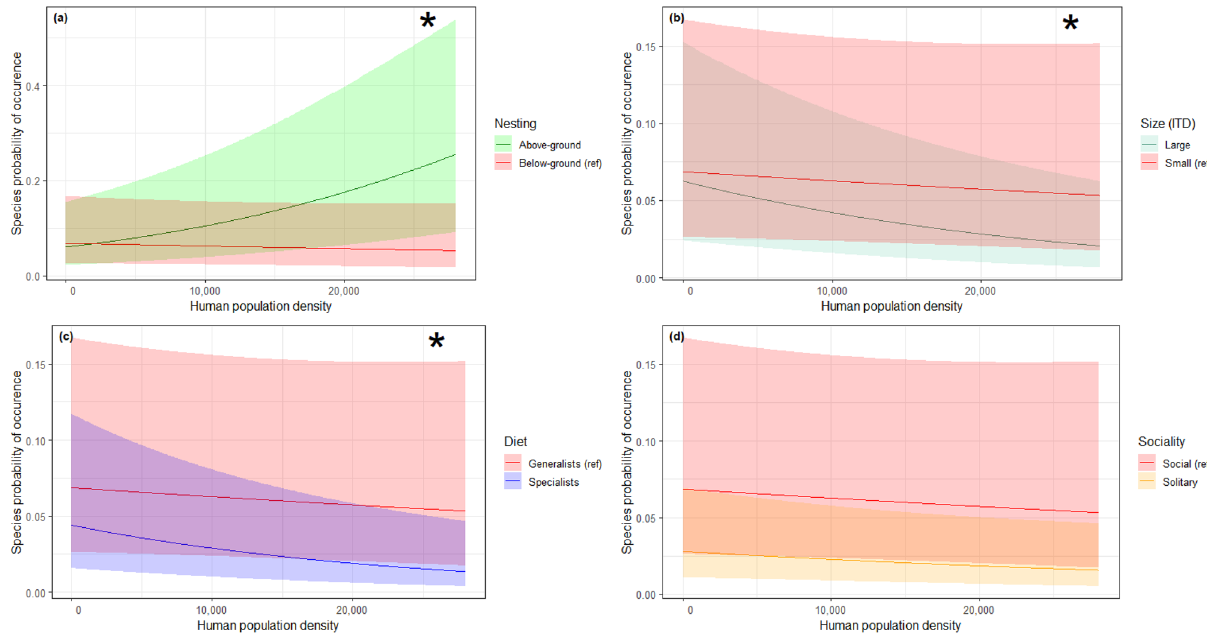
Figure 3. Bee species probability of occurrence as a function of human population density and functional trait modalities. Model predictions are plotted separately by trait modalities, so as to highlight the statistical interactions that may support an ecological filter hypothesis, i.e. different slopes between two modalities of a given trait. In each panel, the reference modality handled by the model (red curves, with a “ref” legend tag) was chosen on the basis of the most abundant species in the dataset, namely Lasioglossum malachurum , a small-sized species nesting below ground, with generalist diet and social habits. Shaded areas stand for the 95% confidence interval of these predictions. The plots labelled with an asterisk indicate a significant trait modality-human population density